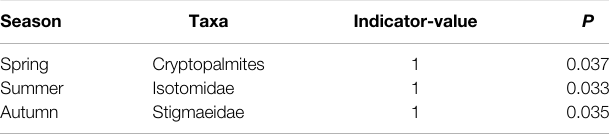
TABLE 2 | Result of indicator species analysis of three seasons in the Urad desert